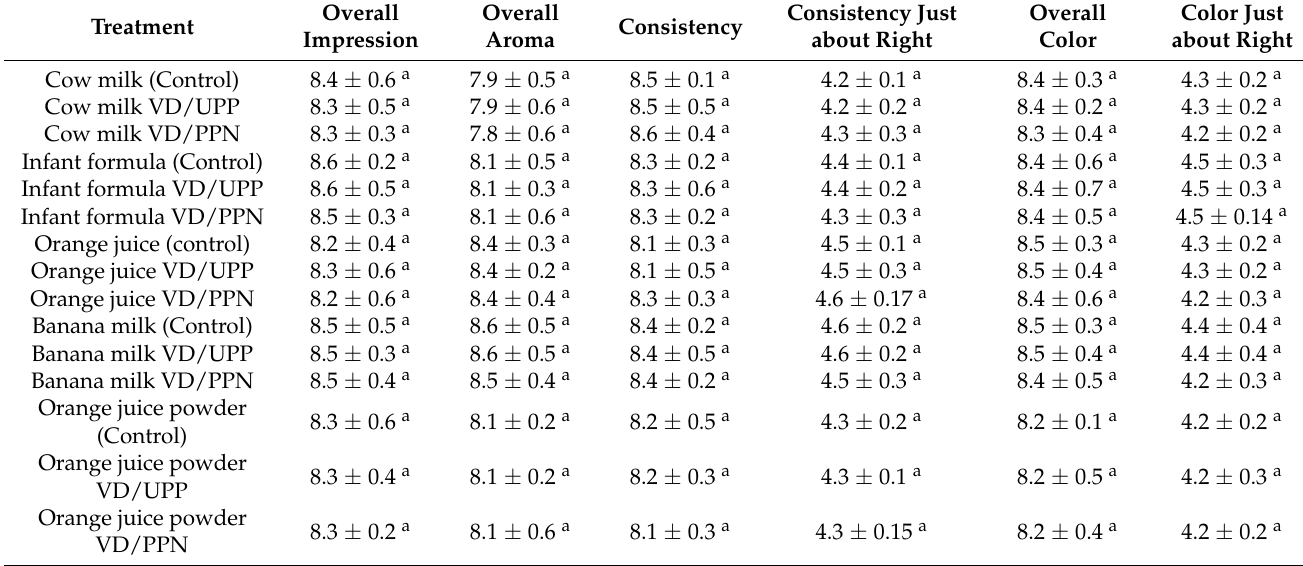
Table 7. Quantitative descriptive analysis of various food products after vitamin D fortification using UPP and PPN.